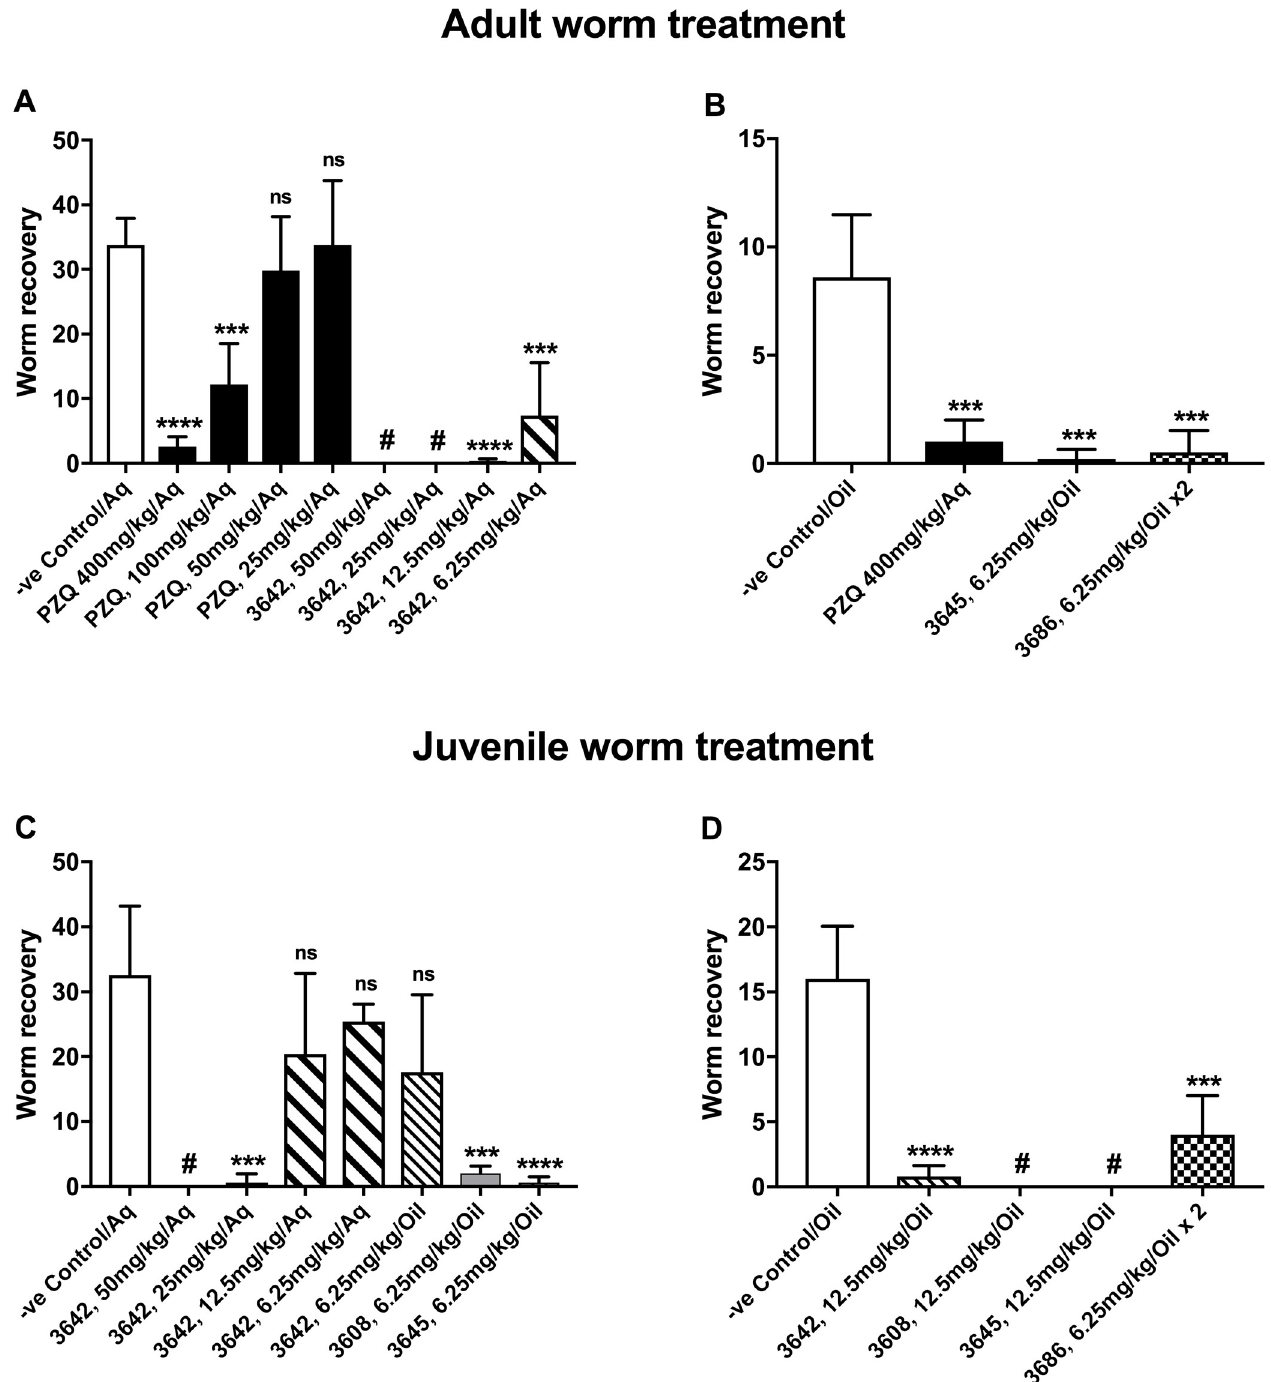
Fig 9. In vivo demonstration of efficacy. Graphs show the Mean (+ standard deviation) worm recoveries following single oral dose treatment with vehicle or vehicle plus drug of infections in mice (n = 5), #—no worms recovered (ie complete cure in all mice). The formulation of drug (or control) was either Aq (Drugs were suspended in 7% Tween-80 / 3% Ethanol / double distilled water and drug dispersal was facilitated by vortexing and using a sonicating water bath) or oil (Drugs were first dissolved in DMSO, then diluted with corn oil to give a 1:19 DMSO/corn oil ratio. Panel A shows a head to head comparison between PZQ and LSHTM-3642 in vivo against adult worms with a single oral dose giving PZQ an EC 50 between 50 and 100 mg/kg and LSHTM-3642 an EC 50 below 6.25 mg/kg. Panel B A demonstration of good efficacy from two compounds with low in vitro EC 50 values. LSHTM-3645 was used with a single oral dose, LSHTM-3686 was dosed twice, 12h apart because it has a shorter (6h) murine half-life than some of the other compounds shown. Panel C A dose response experiment showing that LSHTM-3642 has an EC 50 against juvenile worms in vivo of between 12.5 & 25 mg/kg. The experiment also shows that both